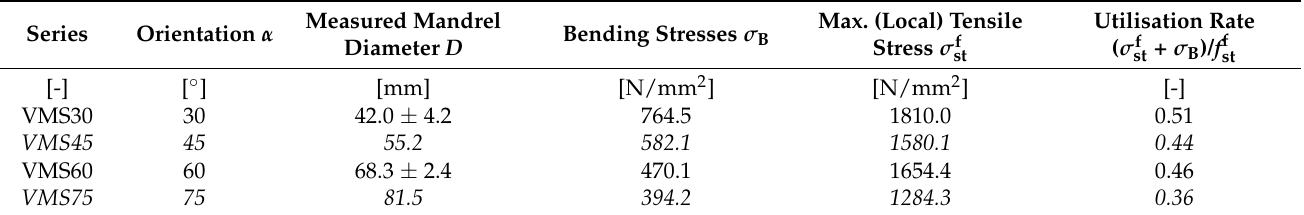
Table 3. Calculated mean utilisation rate of pulled out fibres in UHPC under quasi-static loading.